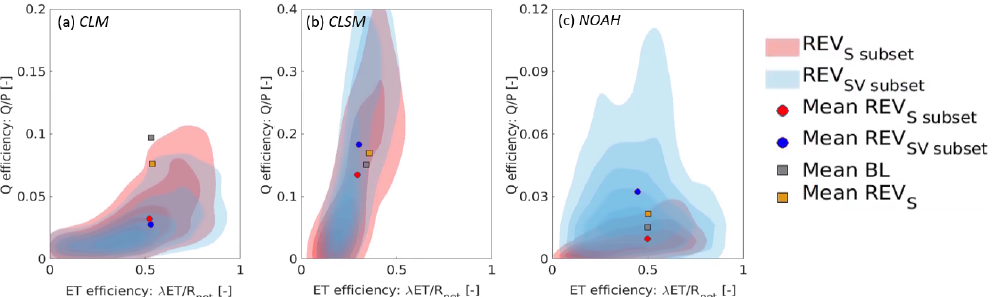
Figure 9. Scatter clouds in efficiency space for the REV S (red) and REV SV (blue) experiment for a subset of 197px (corresponding to deforested pixels between 2002 and 2006) for the period 2007–2015, together with the mean value for (a–c) CLM, CLSM and NOAH, respectively. The gray and orange dots represent the shift in mean efficiency between the BL and REV S simulations, based on all pixels inside the Dry Chaco; i.e., the mean BL values correspond to those in Fig. 8c, f and i.